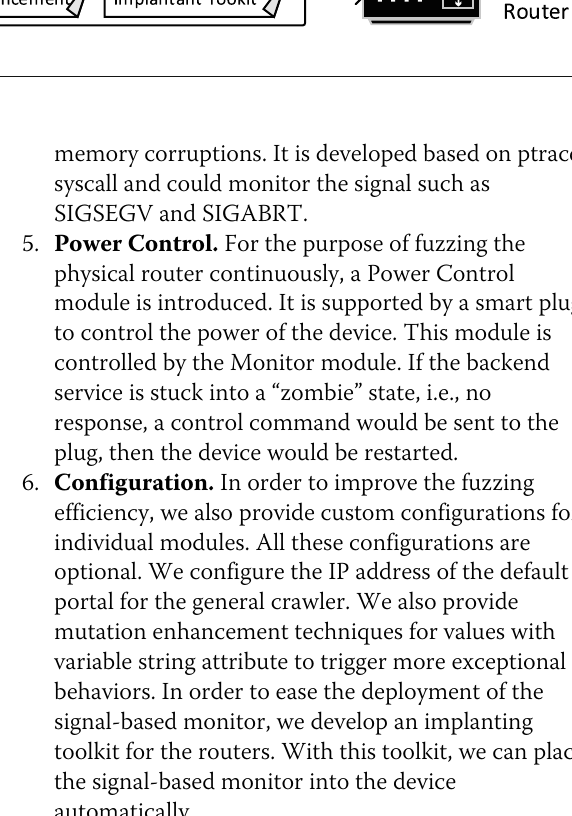
Fig. 6 Overview of ESRFuzzer